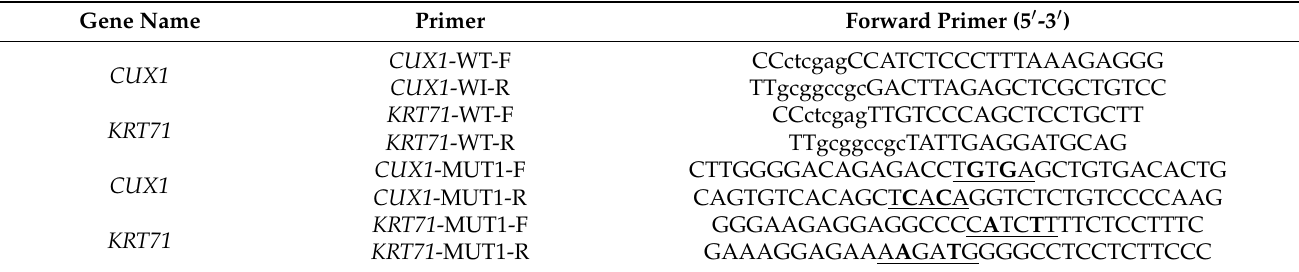
Table 2. The primer for construction of